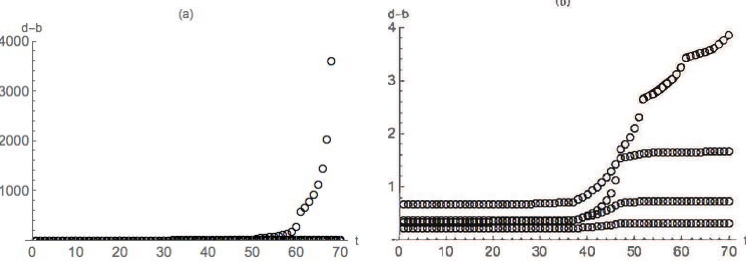
Figure 12. Lifespans d − b for β 0 computed for ( a ) Nx = 25 and ( b ) Nx = 50 triangulations.